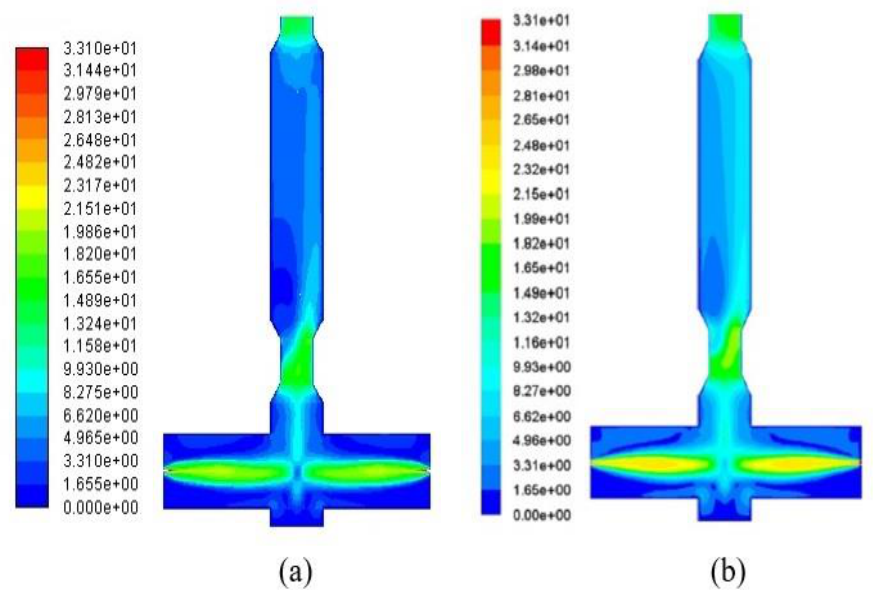
Figure 5. Comparison of velocity (m/s) distribution along the central plane for ( a ) the current study and ( b ) Ma et al. (2012) [8].